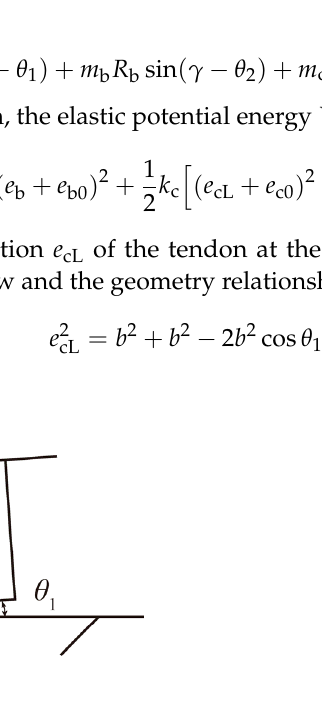
e of the tendon at the base of the left cL